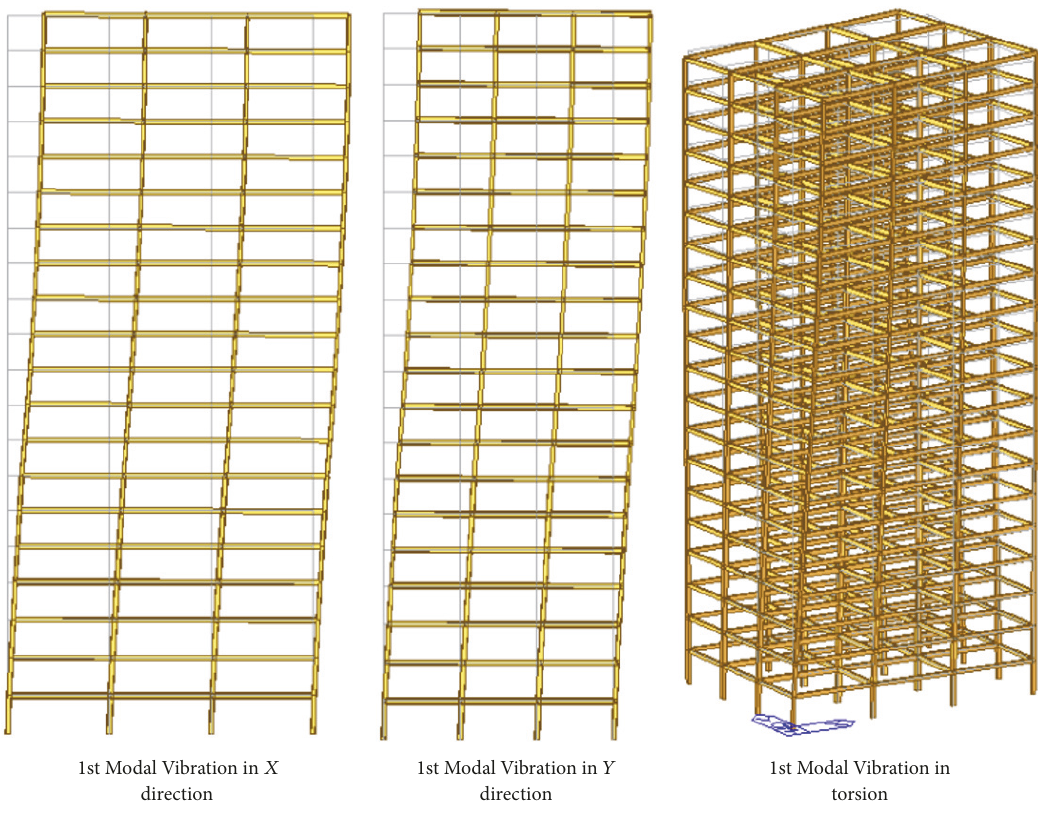
Figure 13: Mode shapes of a 20-story steel structure.